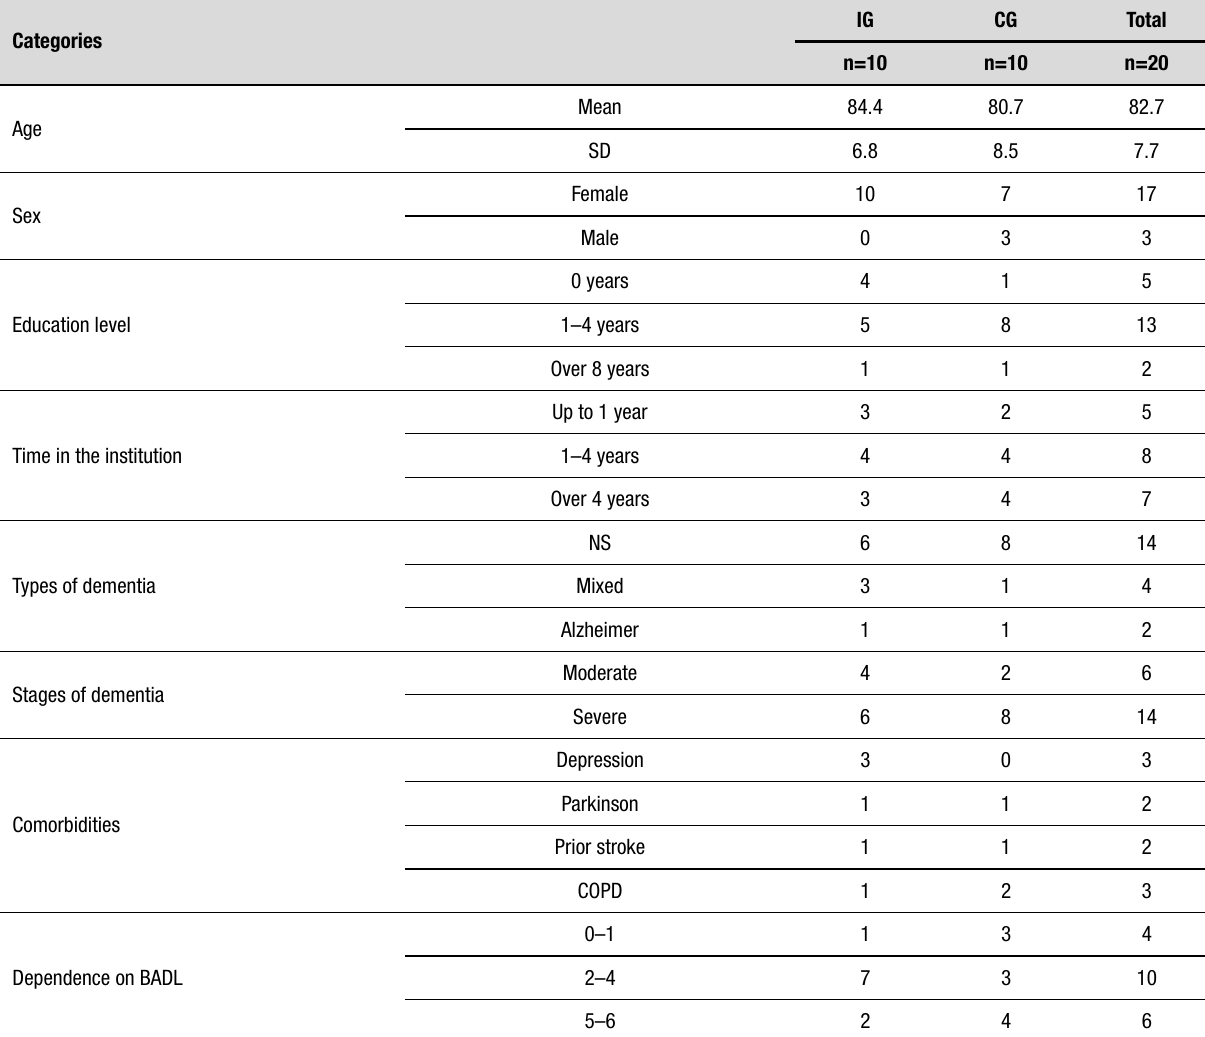
Table 1. Characterization of the intervention group and control group regarding age, sex, education level, time in the institution (in years), types, and stages of dementia, comorbidities, and